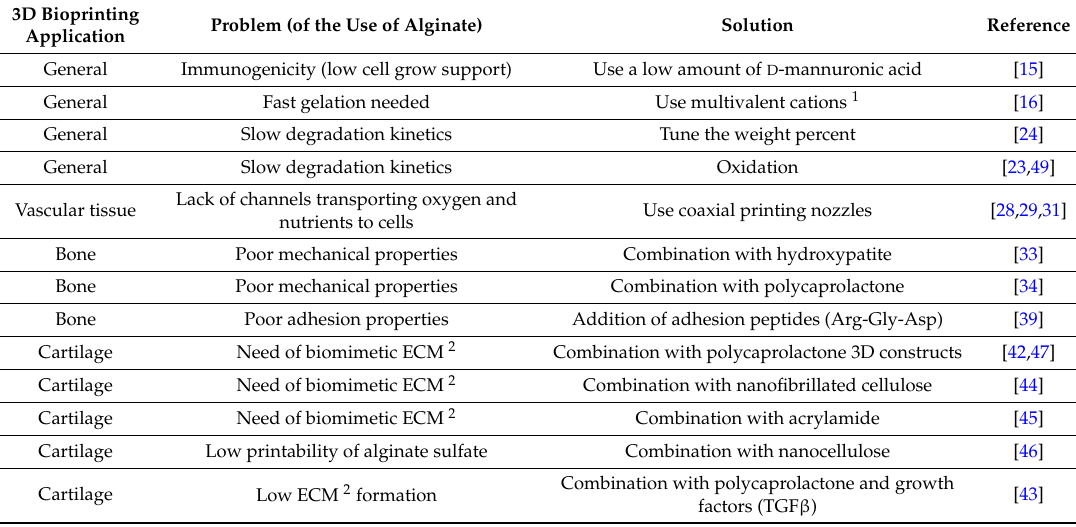
Table 1. Problems and given solutions of using alginate as a bioink in different three-dimensional (3D) bioprinting